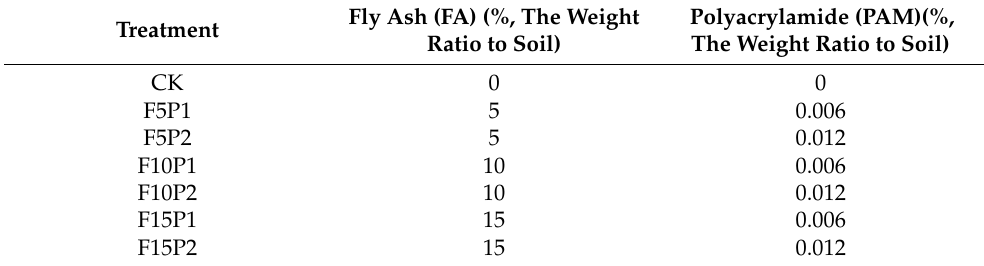
Table 1. Design of experiment.